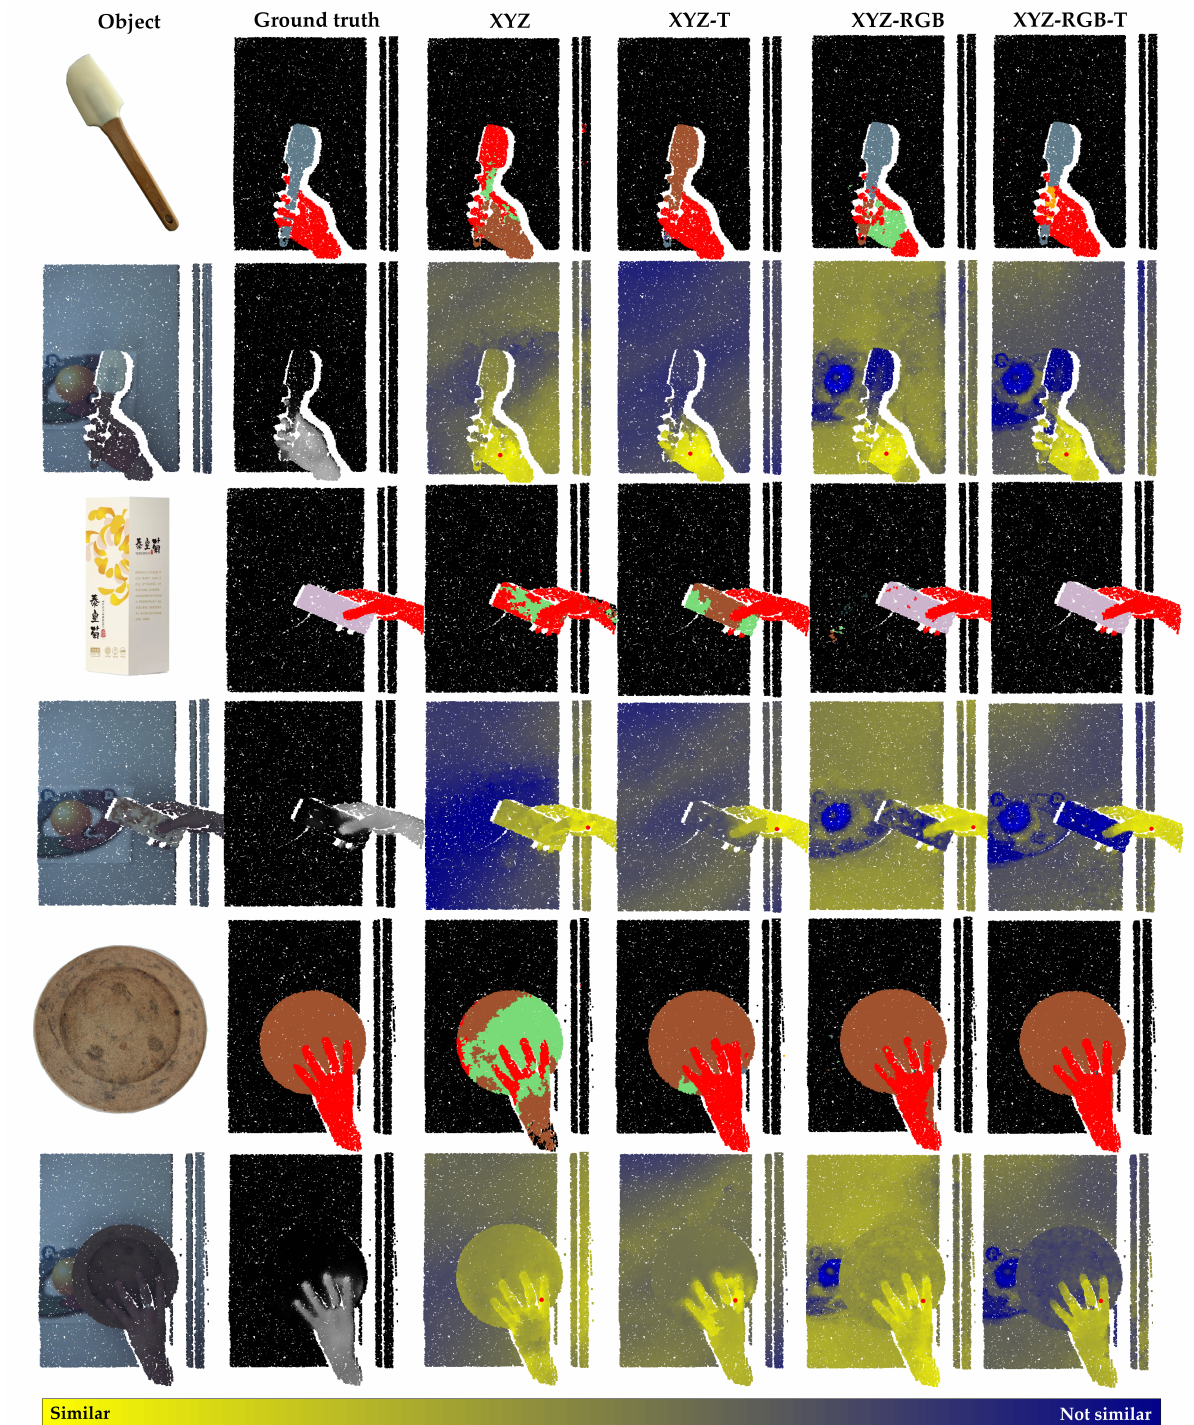
Figure 9. Visualization of experimental results for RandLA-Net on individual samples of the test dataset: The first row shows the ground truth and segmentation by XYZ, XYZ-T, XYZ-RGB, and XYZ-RGB-T, while the hand class is labeled in red. The second row shows the color point cloud, thermal point cloud, and the feature point cloud generated by XYZ, XYZ-T, XYZ-RGB, and XYZ-RGB-T. In the feature point cloud, the euclidean distances between a reference point (red point) and all other points are calculated and normalized in features space. The distances are color coded (light yellow—similar points, dark blue—dissimilar